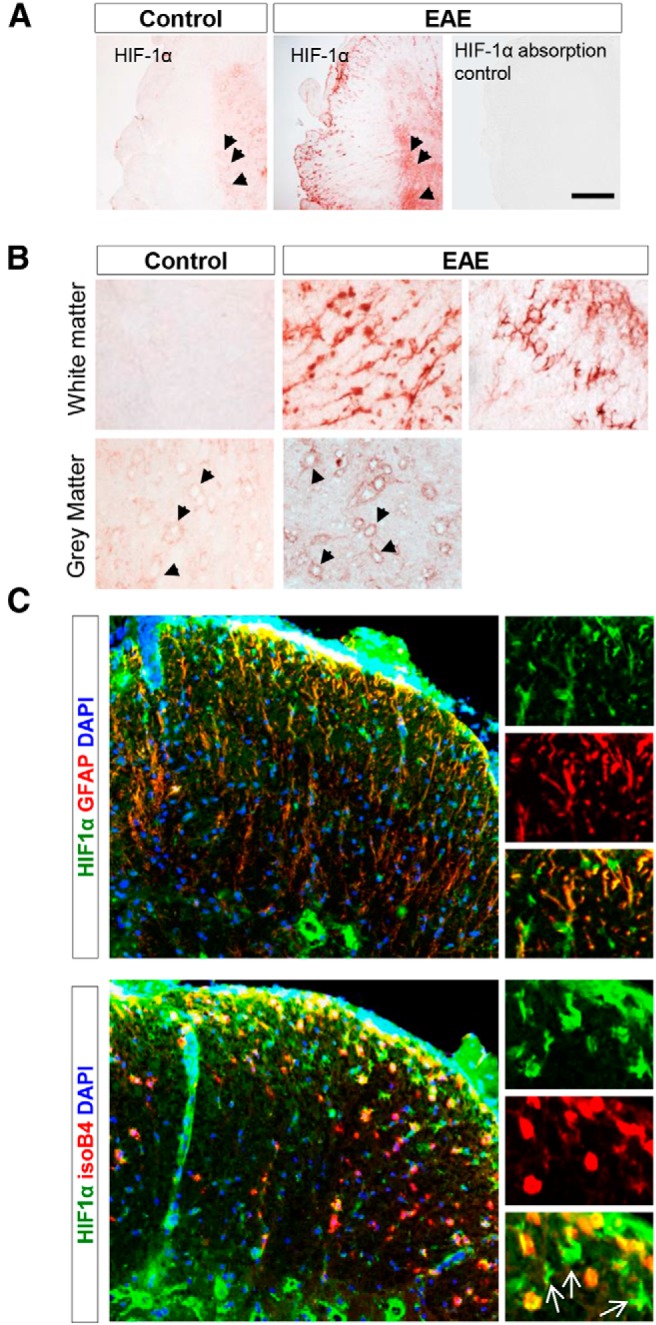
HIF-1α is expressed in astrocytes and microglia/macrophages in the spinal cord of EAE mice. A, Immunohistochemical staining for HIF-1α in spinal cord sections from healthy mice and at peak EAE, 17 d p.i. Absorption control after anti-HIF-1α antibody incubation with HIF-1α blocking peptide at peak EAE. Scale bar, 300 μm. Arrows indicate neuronal cells. B, Higher-magnification of HIF-1α immunostaining in the grey and white matter of the spinal cord of healthy and EAE mice. Scale bar, 50 μm. Arrows indicate neuronal cells. C, Double-immunofluorescence with antibodies against HIF-1α (green) and GFAP (top) or isoB4 (bottom) (red) of spinal cord sections of EAE mice 17 d after immunization. Scale bar, 50 μm. Arrows indicate HIF-1α+isoB4– cells with astrocyte-like morphology (green).